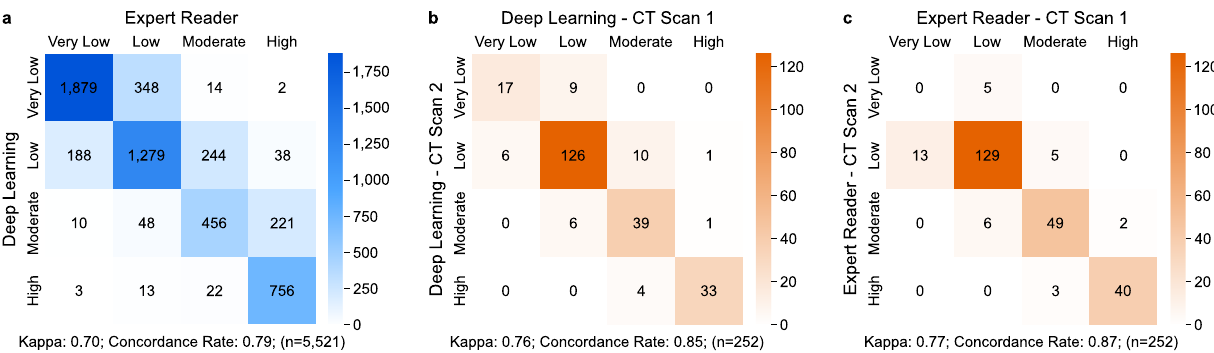
Fig. 3 Confusion matrices to compare automatic and manual CAC quanti fi cation and to assess test – retest repeatability. a Comparison of CAC classes calculated by the deep-learning framework and expert readers, combining data from FHS-CT2, NLST, PROMISE, and ROMICAT-II ( n = 5521). The robustness of b the deep learning framework and c expert readers to quantify CAC was assessed in 252 FHS-CT1 subjects who underwent two subsequent CT scans within 1 h (Scan 1 and Scan 2). CAC coronary artery calcium, FHS-CT1 17 , FHS-CT2 17 Framingham Heart Study, (CT1) participants from the seventh examination cycle of the offspring cohort or fi rst examination cycle of the Third Generation Cohort (2002 – 05) and (CT2) participants from the second examination cycle of the Third Generation Cohort (2008 – 11), NLST 18 National Lung Screening Trial, PROMISE 19 Prospective Multicenter Imaging Study for Evaluation of Chest Pain, ROMICAT-II 20 Rule Out Myocardial Infarction using Computer Assisted Tomography II, CAC risk groups: very low: